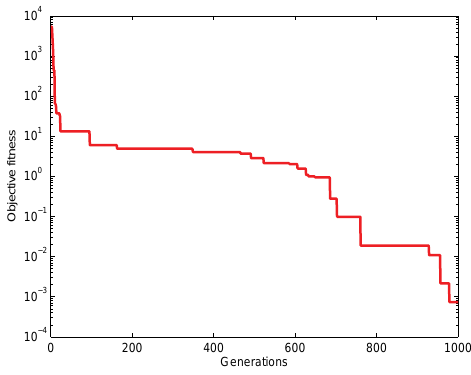
Figure 7: Objective fitness of Scha ff er’s f6 function in the evolutionary process